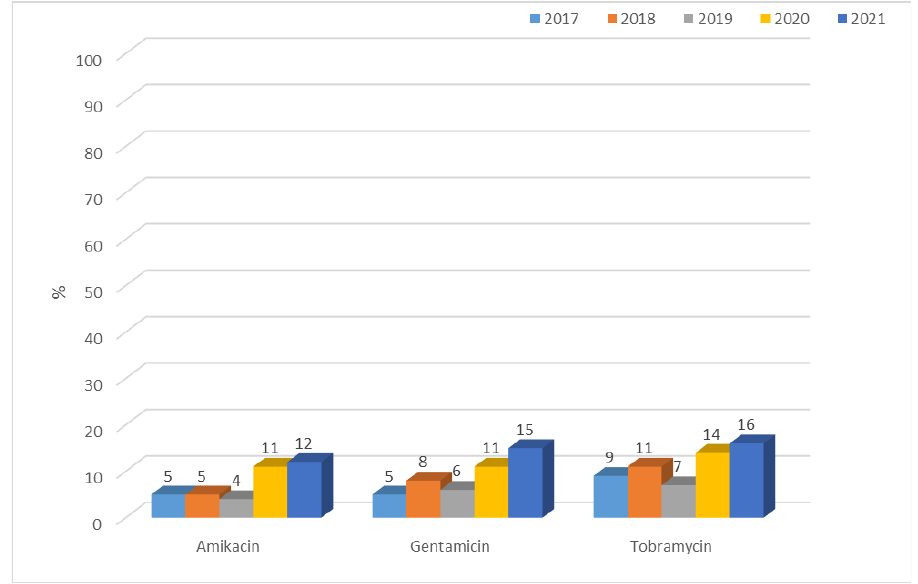
Figure 19. Percentage of K. pneumoniae ESBL(−) strains resistant to aminoglycosides.